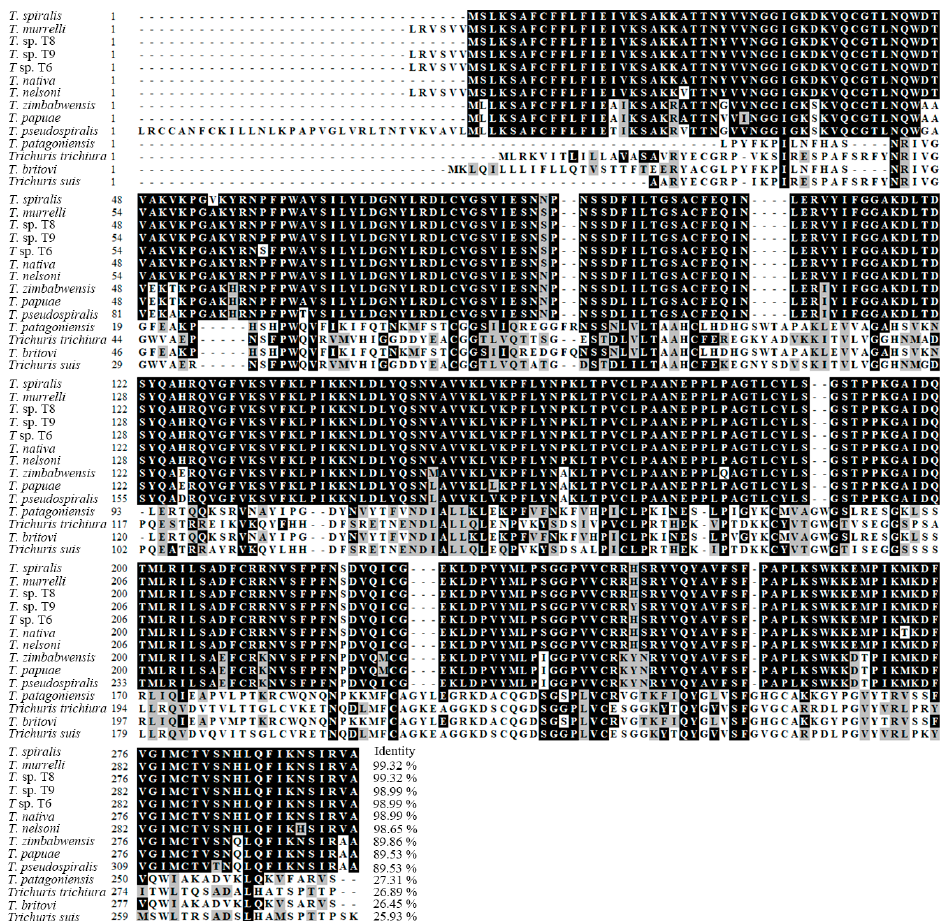
Figure 2. Sequence alignment of Trichinella spiralis trypsin gene (GenBank: XP_003374437.1) with other Trichinella species/genotypes and Trichuris suis . The sequences of trypsin from various organisms were analyzed using Clustal W, the obvious difference was found in diverse Trichinella species or genotypes. Black shade represents the same residues with TsT, and grey shade indicates the conservative substitutions.